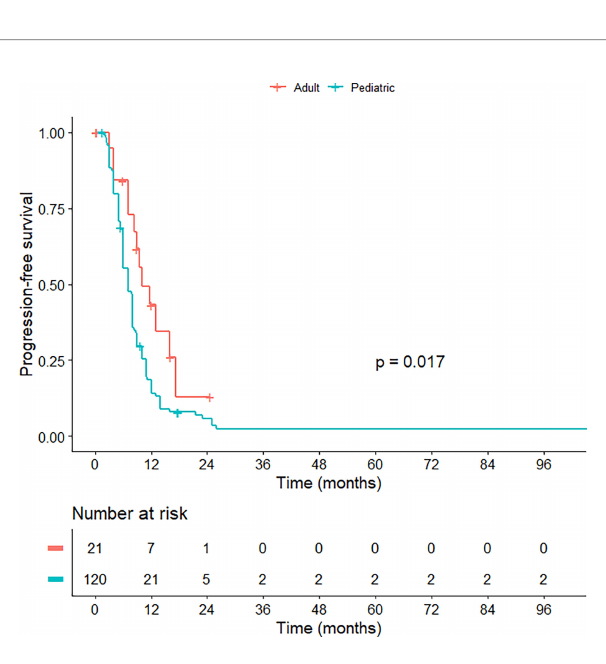
FIGURE 3 | Kaplan-Meier curve illustrating the progression-free survival of pediatric versus adult H3 K27M-mutant midline gliomas.